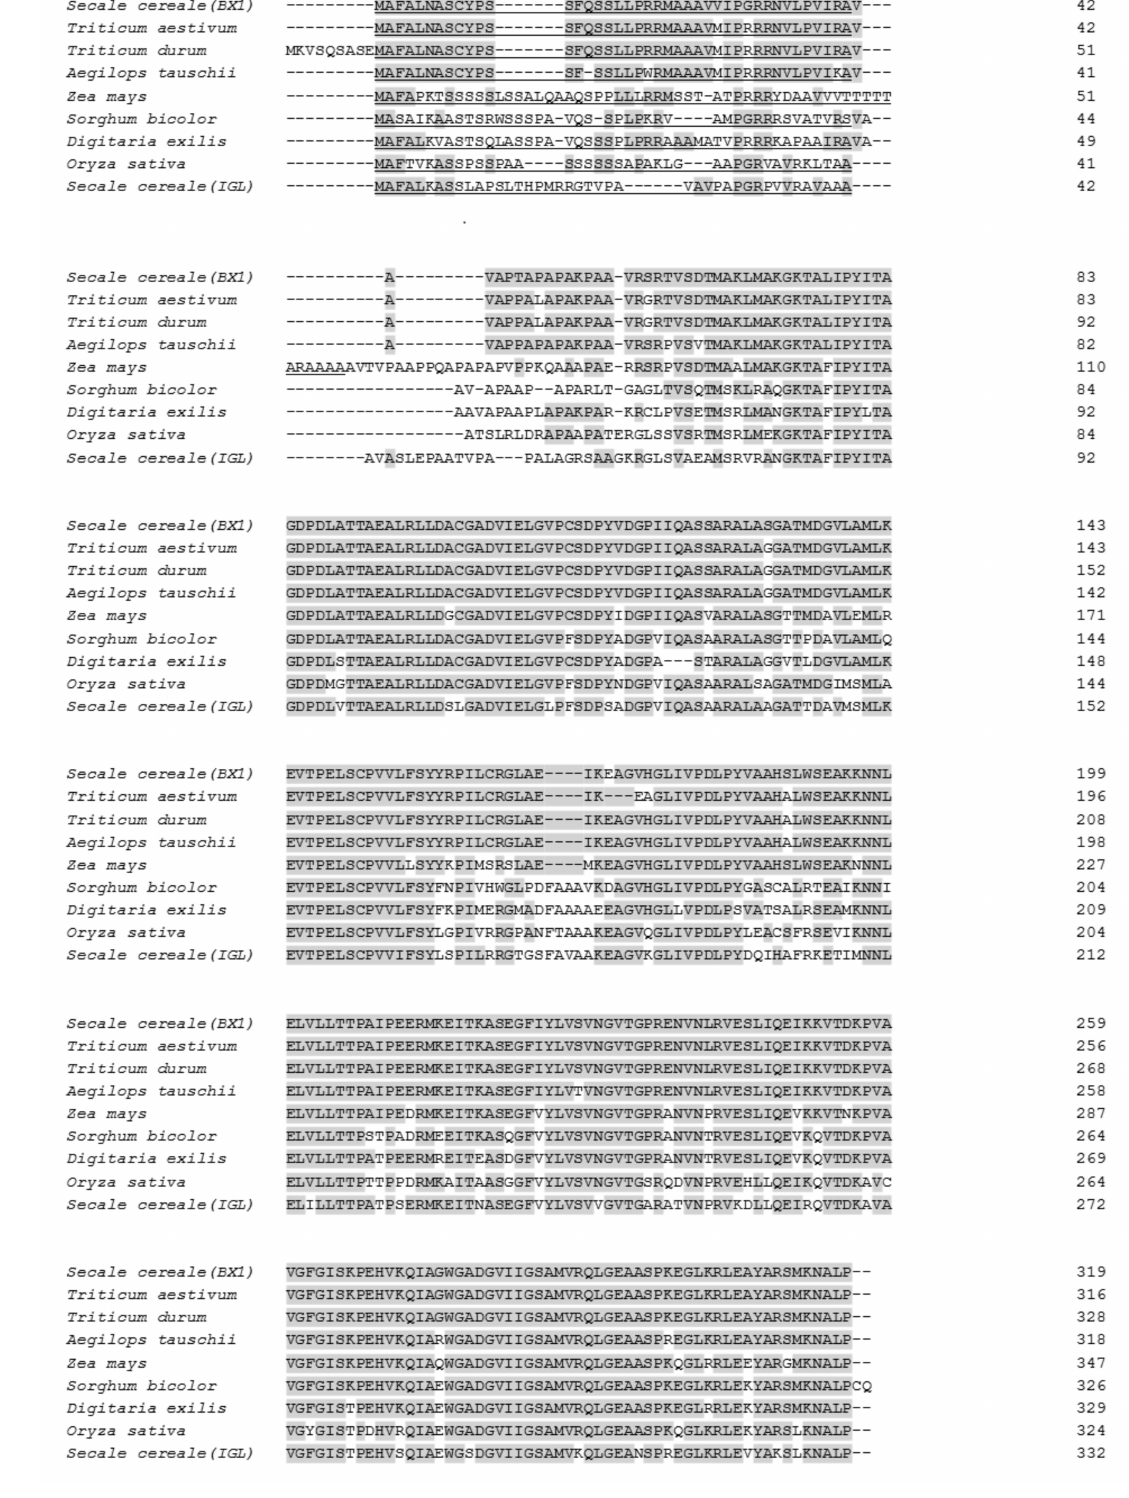
Figure 3. Amino acid sequence alignment of BX1 and other lyases from Triticum aestivum (Acc. No. KAF7049523), Triticum turgidum (Acc. No. VAI07221), Aegilops tauschii (Acc. No. XP_020172362), Zea Mays (Acc. No. NP_001105219) Sorghum bicolor (Acc. No. XP_002463738), Digitaria exilis (Acc. No. CAB3497862), Oryza sativa (Acc. No. XP_015633113), and Secale cereale (Acc. No. QIB84921). Residues identical between BX1 and all other proteins are shaded. Putative chloroplast transit peptides of proteins as predicted by the TargetP 2.0 are